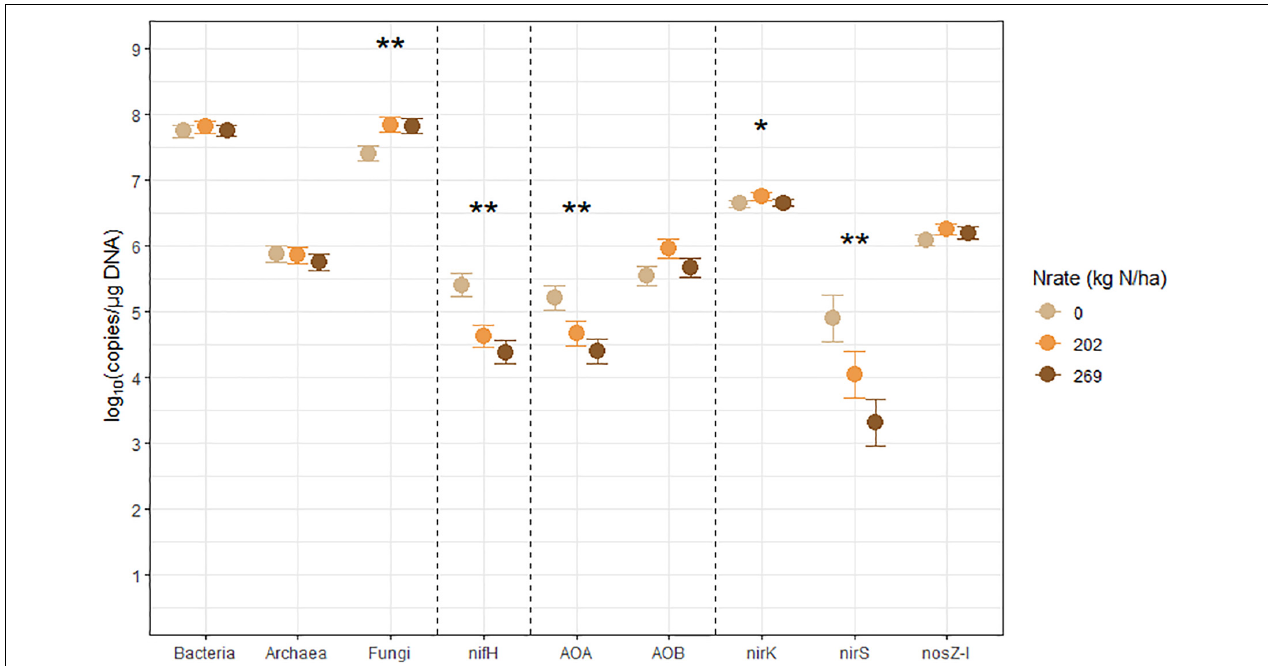
FIGURE 2 | Treatment means of soil microbial marker genes (log 10 copies/ µ g DNA), including bacterial (Bacteria) and archaeal (Archaea) 16S rRNA, fungal ITS region (Fungi), nifH , archaeal (AOA) and bacterial (AOB) amoA , nirK , nirS , and nosZ-I separated by N fertilization rate (Nrate), with their standard errors of the mean as whiskers. Asterisks indicate the level of significance associated with the probability value from analysis of variance of the factors (* p < 0.1, ** p < 0.05). Nrate treatment levels were: 0, 202, and 269 kg N/ha.